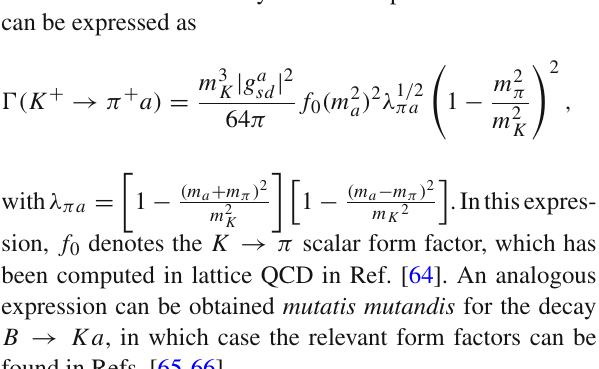
They may contribute to rare decays as illustrated in the left ( c a (cid:7) ) and right ( c W ) panels of Fig. 2. While c W has been discussed separately in Refs. [49,50], and the effective ALP- fermionic interactions have also been considered by them- selves before [48,54–58], the interplay between c W and c a (cid:7) will be shown below to lead to interesting new